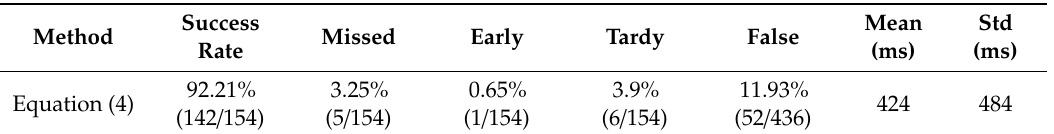
Table 5. Performance of Equation (4) for campaign C31. The models obtained at the end of C30 have been applied to the examples of C31 without any